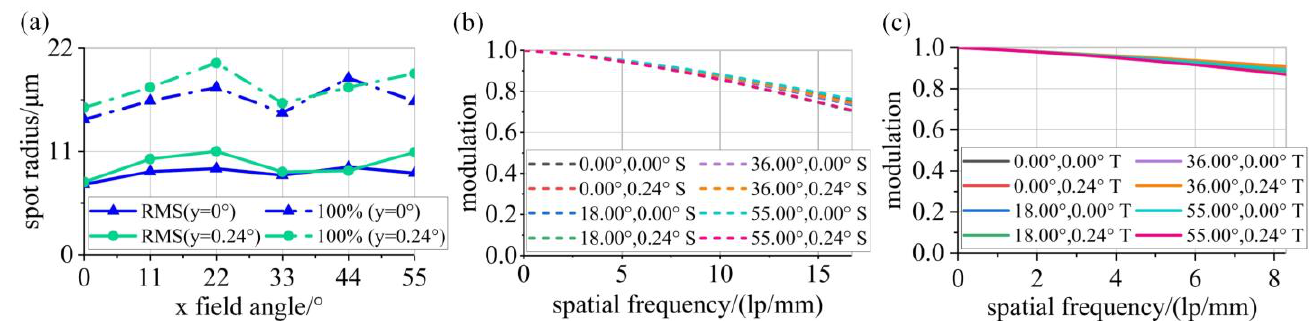
Figure 7. Final designed layout of the compact UFOTAS: ( a ) layout in XOZ plane, ( b ) 3D layout.